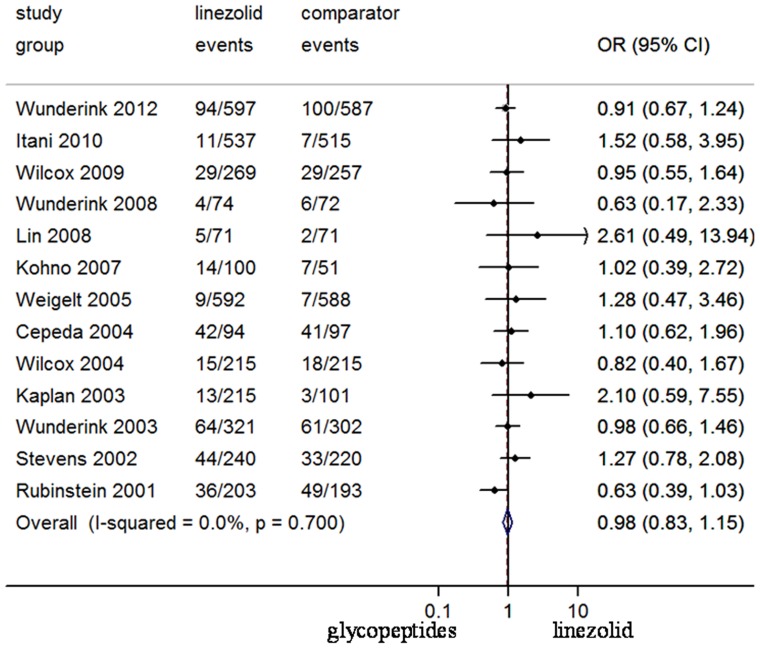
Meta-analysis of mortality in this pooled data.Test of mortality for overall effect: Z = 0.29 P = 0.771.